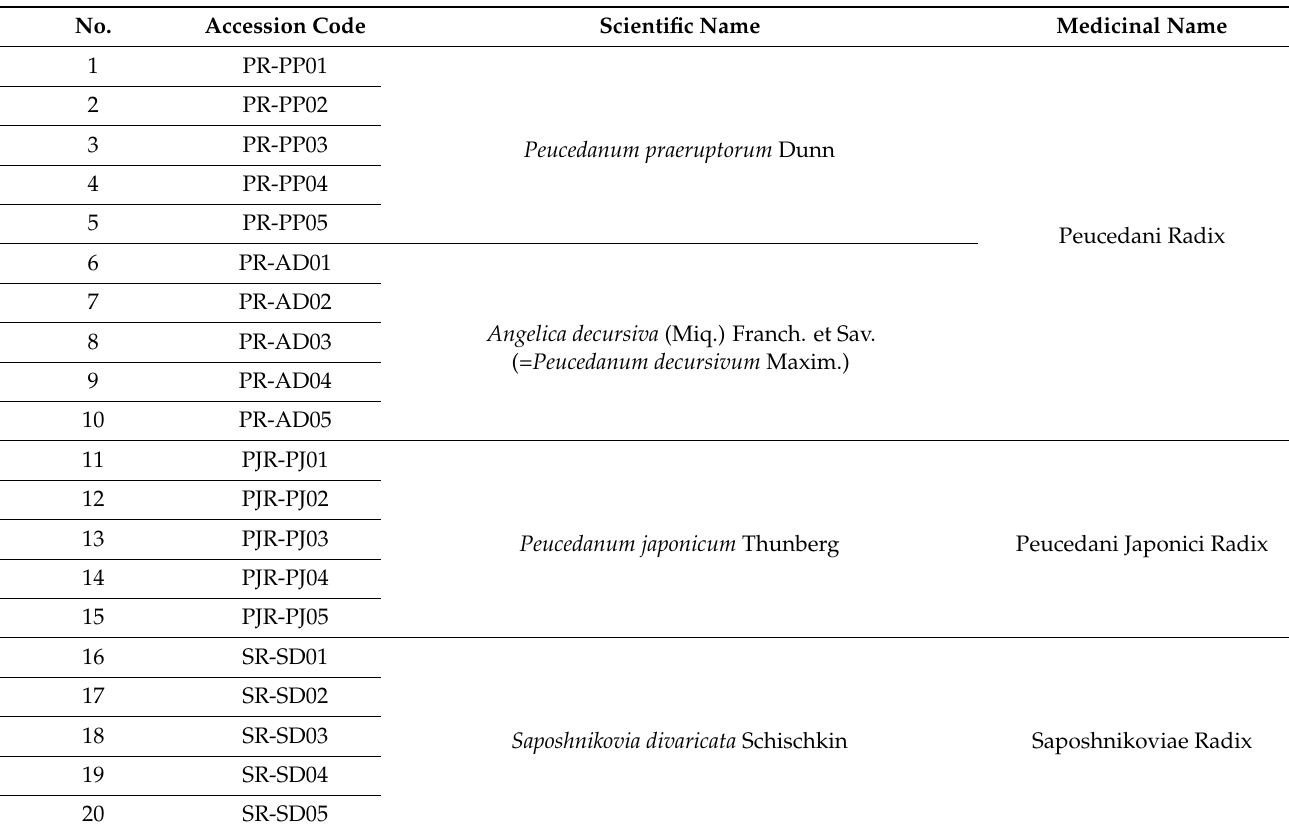
Table 2. List of standard reference samples used for the genetic identification in this study.